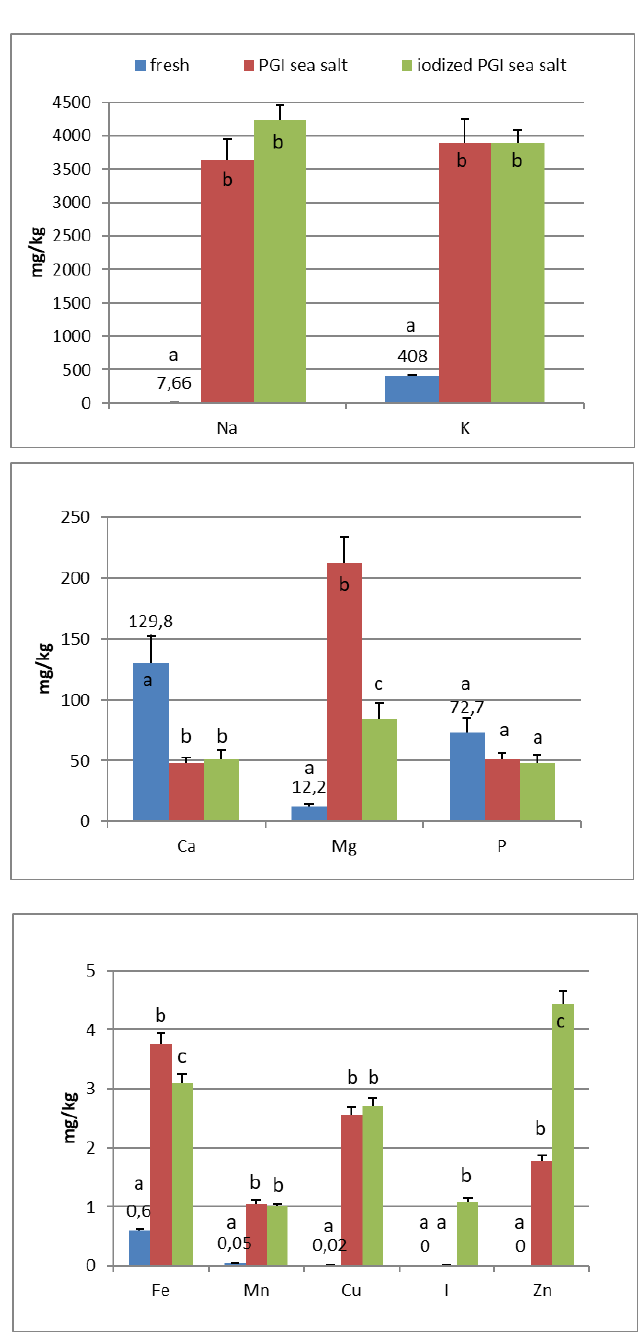
Figure 1. Mineral composition of fresh and processed Carolea olives. Data are expressed in mg/kg. Bars represent mean values of two replicates ± SD. Significant differences are indicated by different letters ( P < 0.05).